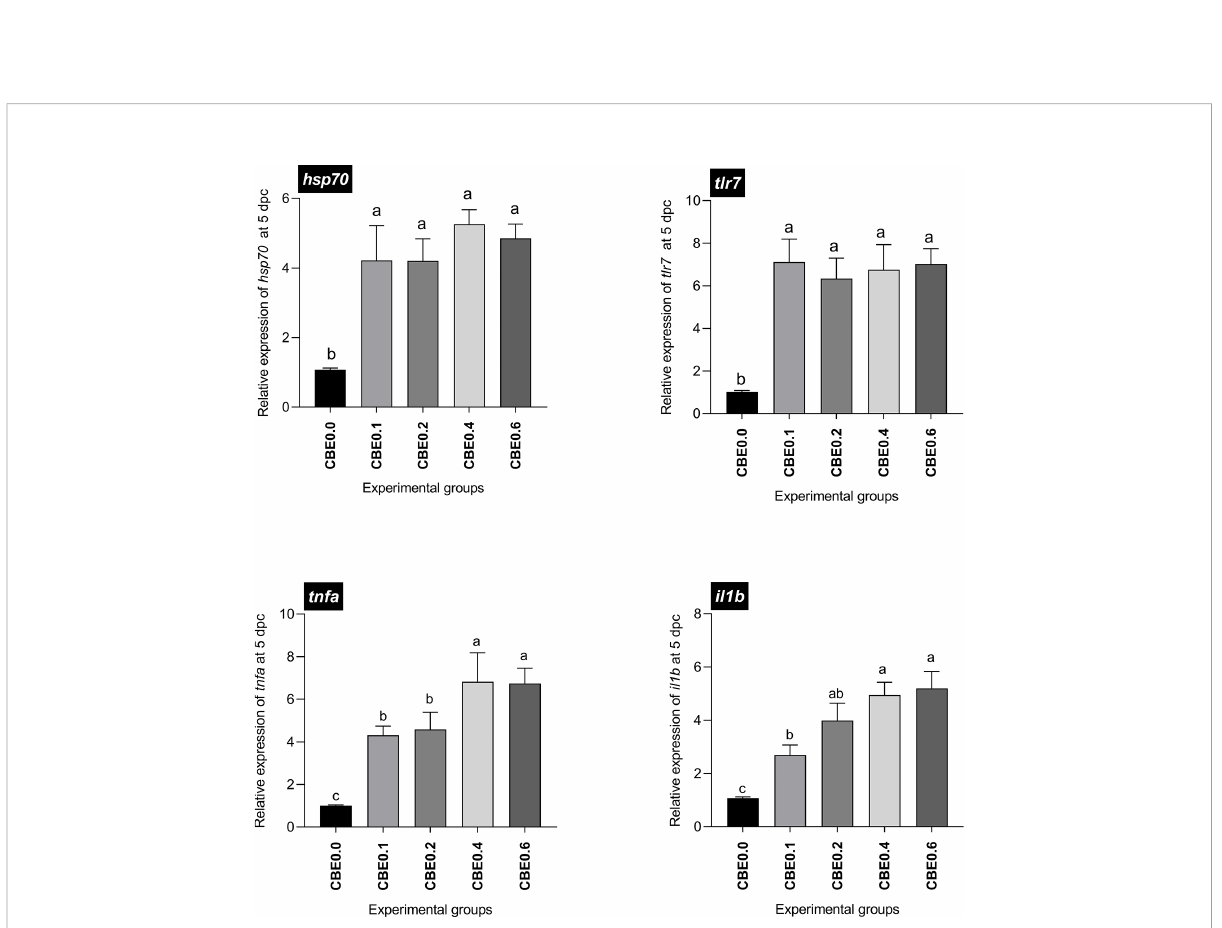
FIGURE 2 Differential expression of immune-related genes in Nile tilapia groups fed different doses of CBE for10 weeks, sampled at 5 days post challenge with Aeromonas hydrophila . il1b , Interleukin 1 beta ; tnfa , tumor necrosis factor alpha ; tlr7 , toll like receptor-7 ; hsp70 , the heat shock cognate 70-kd protein . Columns (experimental groups) with different superscript letters in the same fi gure are signi fi cantly different (p ≤